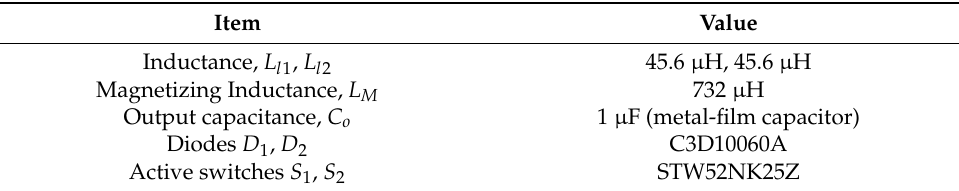
Table 2. Component